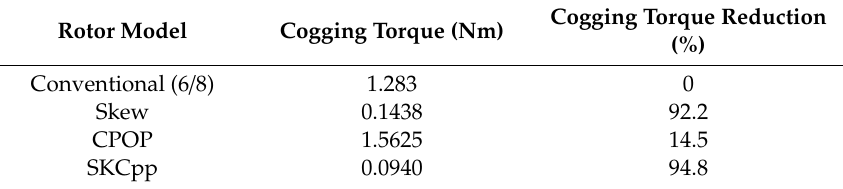
Table 5. Comparison table of reduction of CT for NRE PM FRM at TR-no-load.